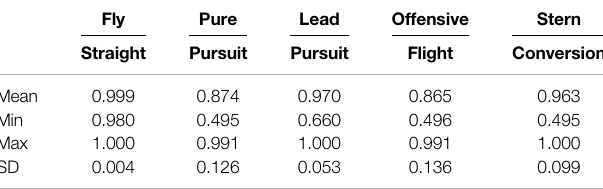
TABLE 2 | Behaviour recognition mean, minimum, maximum and standard deviation of true positive rates.